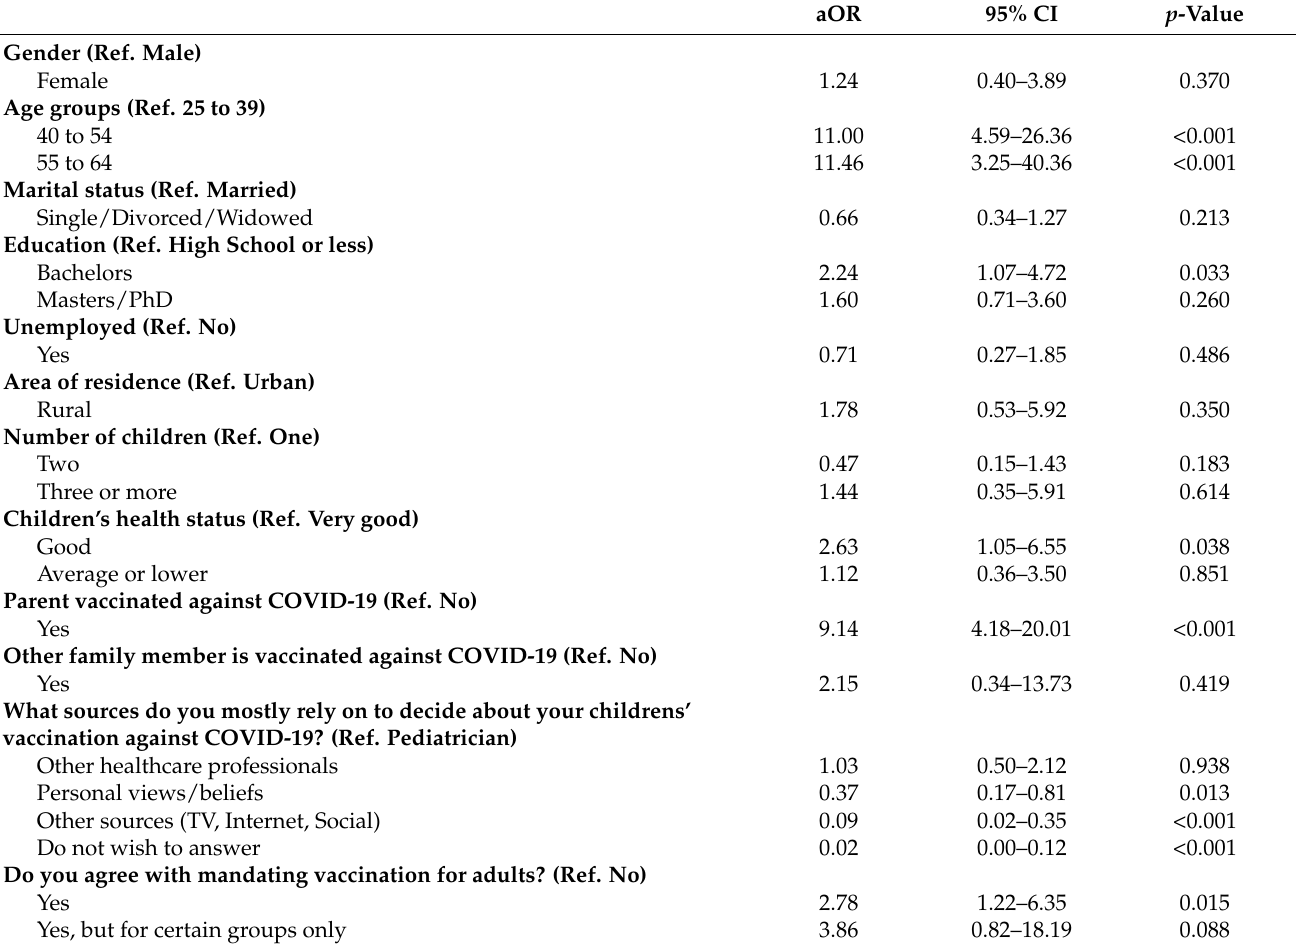
Table 4. Multivariate logistic regression estimates of the association between parental intention to vaccinate their children against COVID-19 and parental characteristics, opinions, and